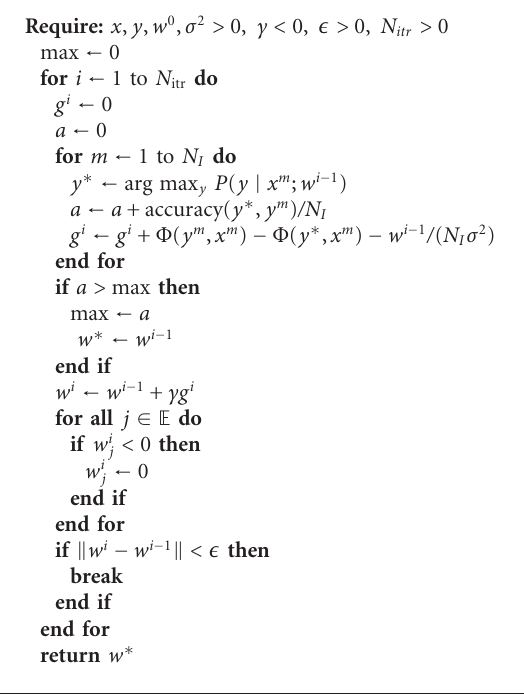
Algorithm 1: Calculating the CRF parameter vector w using gradient descent and saddle-point